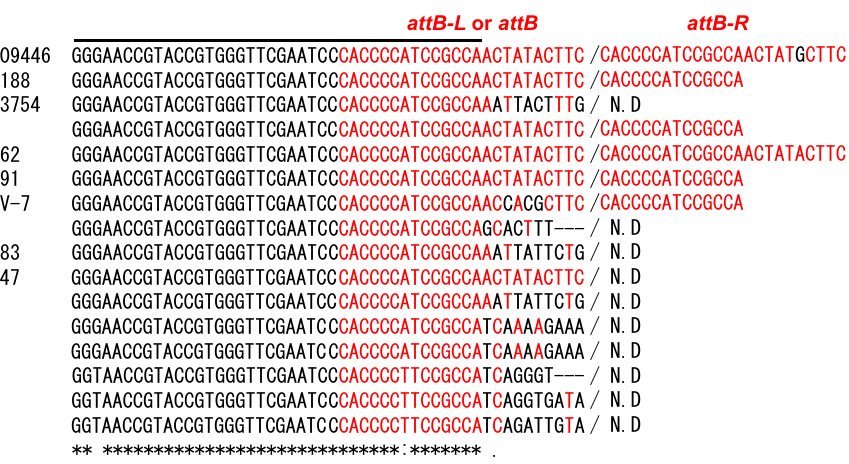
Figure 5. Multiple alignments of attB sites in Acetobacter spp. Nucleotide sequences of the tRNA ser gene and its 3’ flanking region were compared with CLUSTAL W (see Materials and Methods). Anticodon (TGA) was located in the position 35 to 37 bp. The coding sequences of the tRNA ser gene are shown by the line on top of the alignment. Putative attB-L and attB-R are shown in red text. N.D., not detected. Asterisks, colons, and periods are indicative of completely, highly, and semi-conserved nucleotide sequences, respectively.